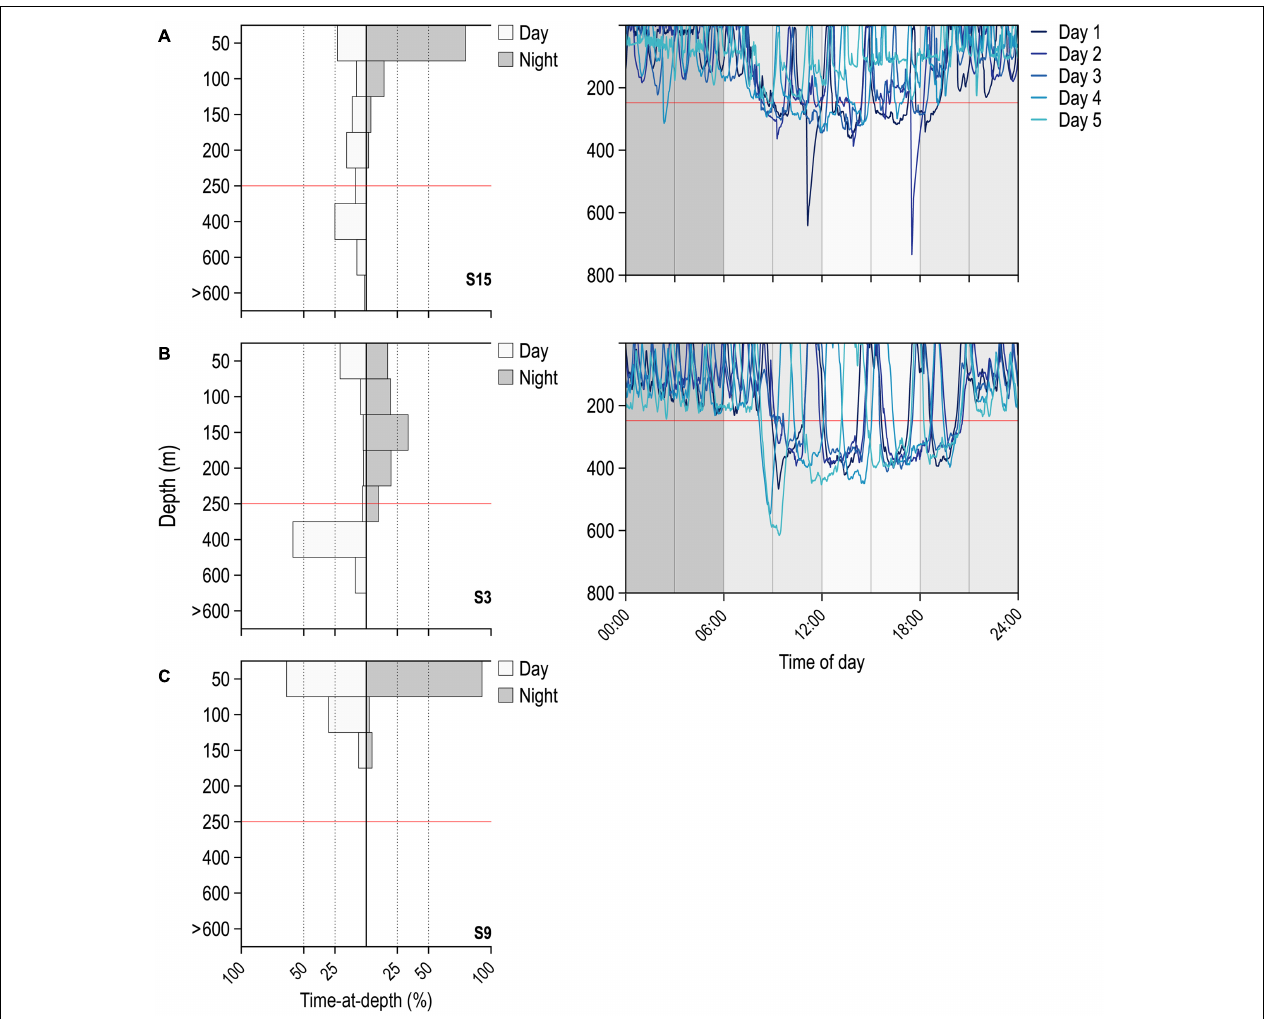
FIGURE 2 | Diel behaviour of blue sharks. Left panel shows the percentage of time-at-depth for day- (white) and night-time (grey) for (A) nDVM (day-time occupancy above 250 m: 66.0%), (B) depth-oriented nDVM (32.7%), and (C) surface-oriented (100%) diel diving behaviours; Right panels show the correspondent 5-day archival depth use. Horizontal red lines denote the depth threshold considered to define each diel class (250 m